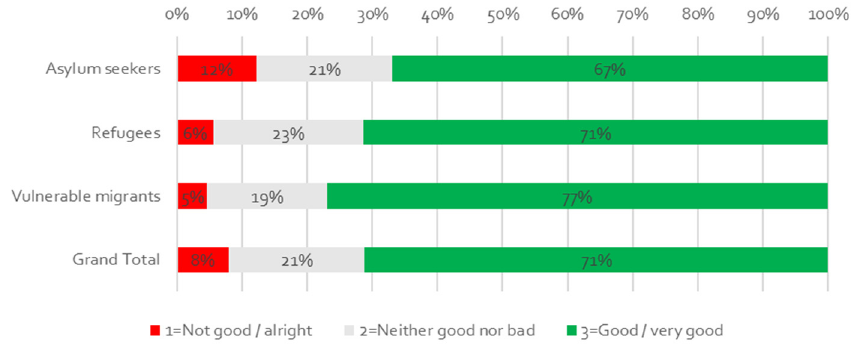
Figure 6. Average skills training.